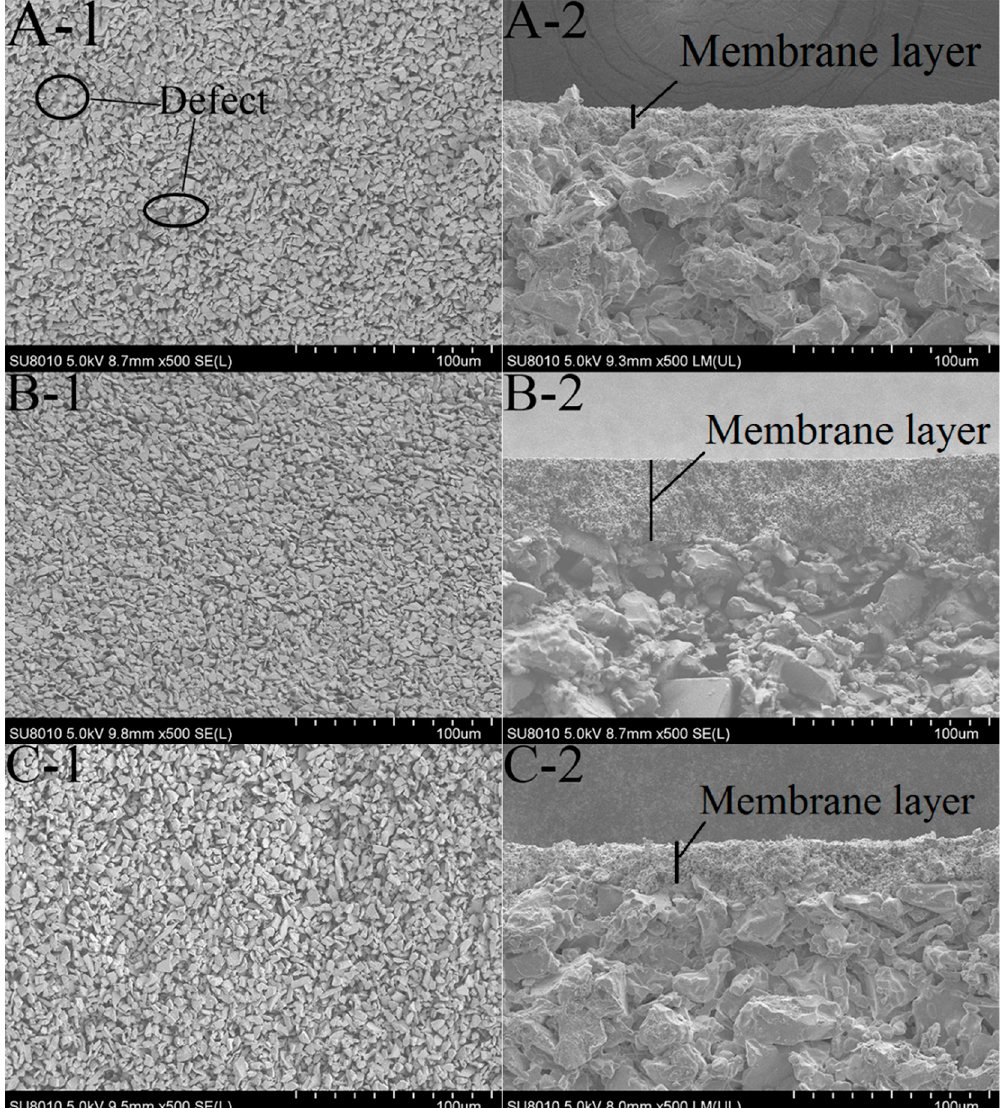
Figure 8. SEM images of the samples with different coating times ( A —5 s, B —11 s, C —17 s; A-1 , B-2 , C-1 are surface images, and A-2 , B-2 , C-2 are cross-sectional images).